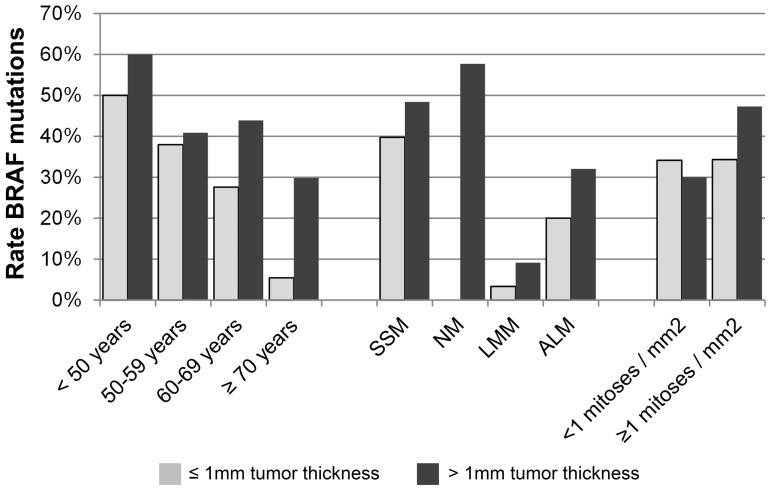
Rate of BRAF-V600 mutations in patients with tumor thickness of 1 mm or less (grey bars) or more than 1 mm (black bars) according to age (left), histological subtype (middle), and mitotic rate (right).SSM – superficial spreading melanoma; NM – nodular melanoma; LMM – lentigo maligna melanoma; ALM – acral lentiginous melanoma.